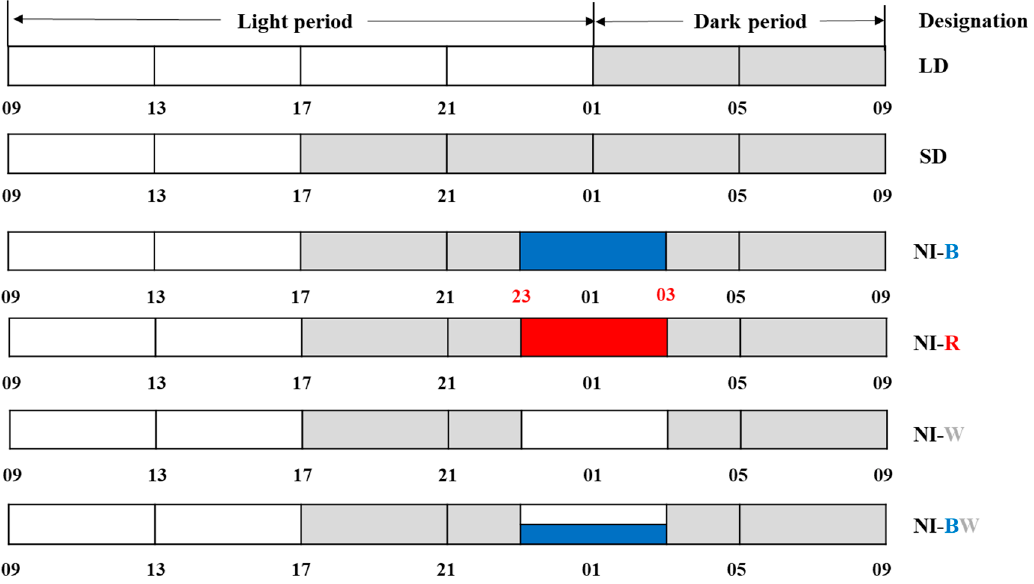
Figure 1. Night interruption (NI) treatments, provided by light emitting diodes (LEDs), used in this study and the night interruption light (NIL) qualities used for 4 h a day during the dark period: NI-B, blue; NI-R, red; NI-W, white; and NI-BW, blue and white. The LD and SD indicate 16 h long day and 8 h short day, respectively.